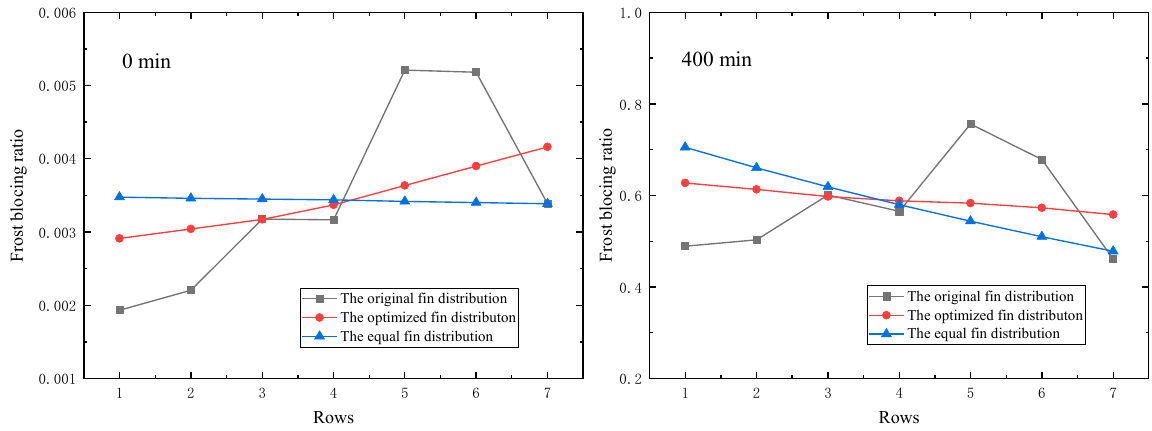
Figure 14. Comparison of frost blockage ratio among three schemes at 0 min and 400 min.